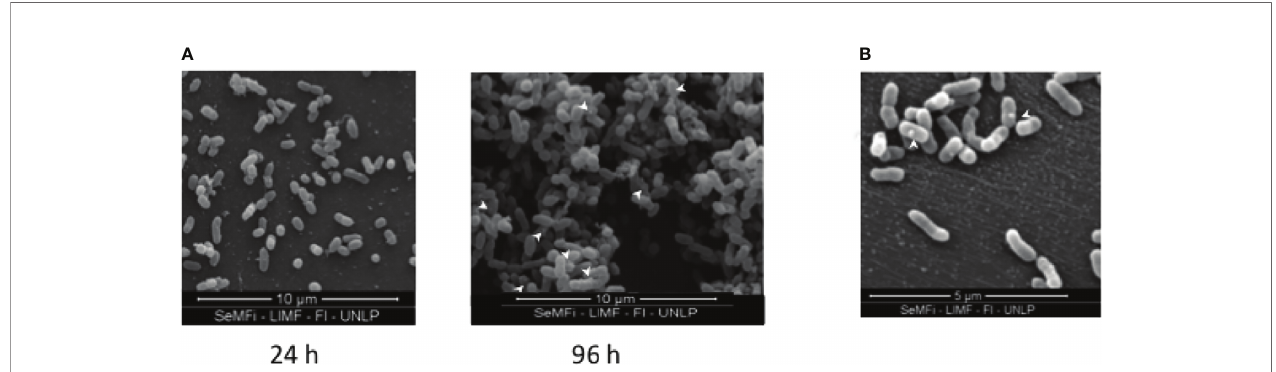
FIGURE 2 | (A) Scanning electron microscopy of B . pertussis BpAR106 bio fi lm culture on abiotic surface at 24h and 96h of growth. For observation through the FEI Quanta 200 electron microscope (24,000 x magni fi cation), the samples were dried by the critical point technique and coated in gold. (B) To visualize the OMV, an electronic zoom of panel (A) is shown. White arrows were used to mark the presence